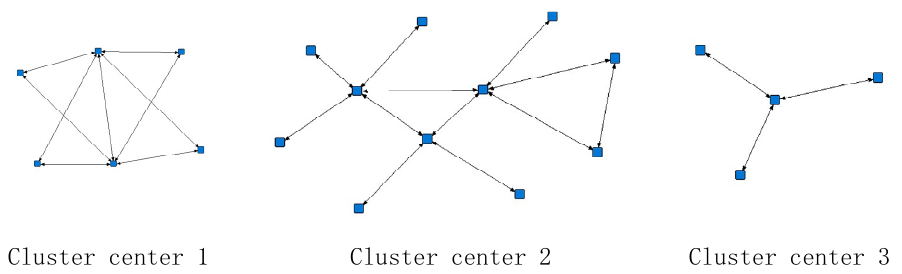
Figure 9. The network structure of the cluster centers.